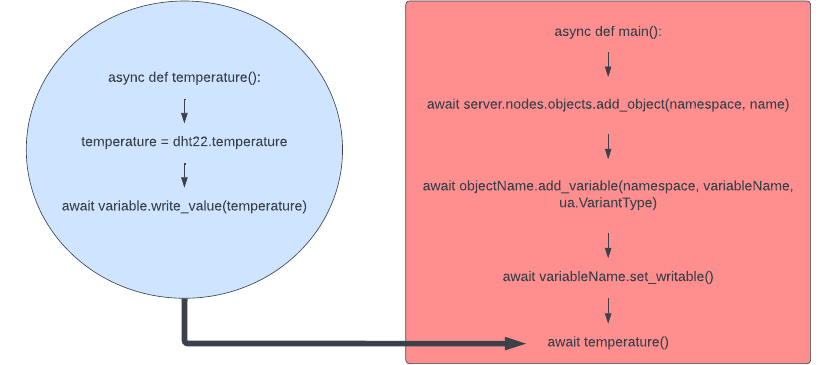
Figure 7. Configuration process of the DHT22